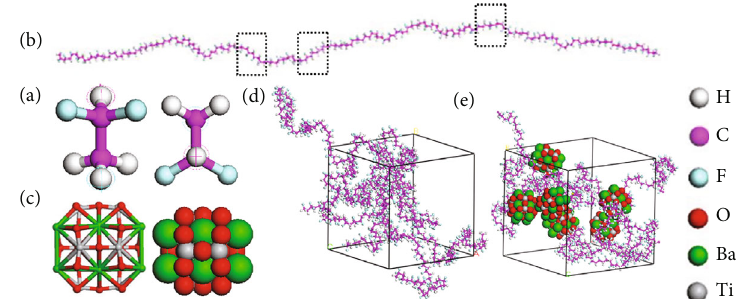
Figure 2: The initial models of PVDF β -phase structural unit (a), PVDF macromolecular chain (b), BT spherical particle (c), PVDF (d), and BT20/PVDF (e).